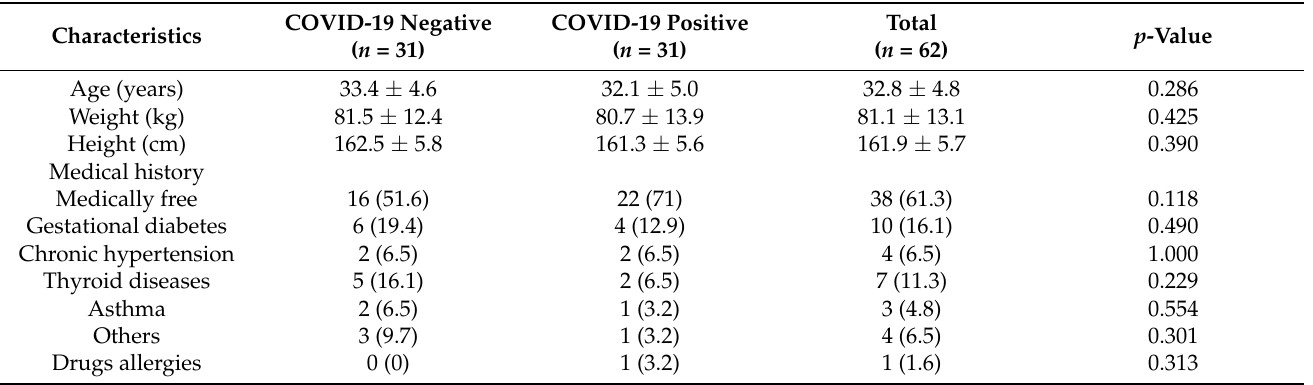
Table 1. Demographics and pre-operative